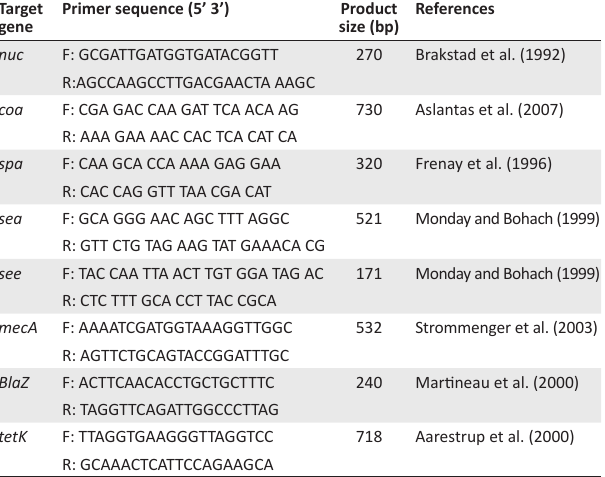
TABLE 1: Sequences of oligonucleotide primers used to target genetic determinants responsible for species confirmation, virulence and resistance in Staphylococcus aureus . Target Primer sequence (5’ gene